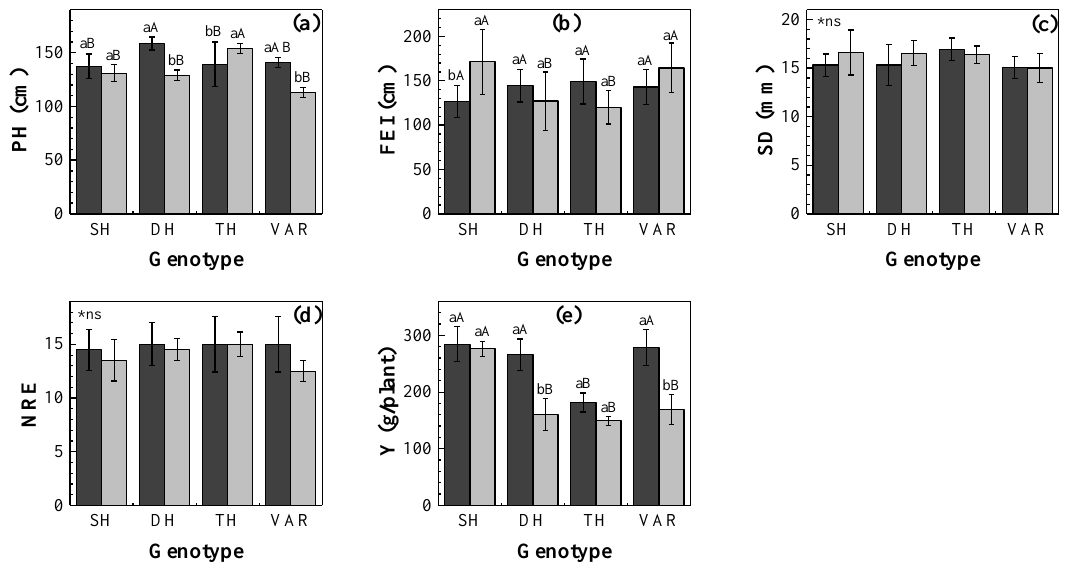
Figure 1. Impact of water-deficit stress on the four maize genotypes in the 1–10 DAE (days after emergence) period: ( a ) plant height (PH, cm); ( b ) height of the first ear insertion (FEI, cm); ( c ) stem diameter (SD, mm); ( d ) number of rows per ear (NRE); and ( e ) yield per plant (Y, g · plant − 1 ). Dark grey bars and light grey bars correspond to without water restriction (WWR) and water restriction (WR) conditions, respectively. Averages followed by the same uppercase or lowercase do not differ by the Tukey test at 5% probability. Lowercase letters compare the values of water regimes (WWR vs. WR) and capital letters compare values among genotypes. The bars represent the mean standard deviations. *ns = not significant.